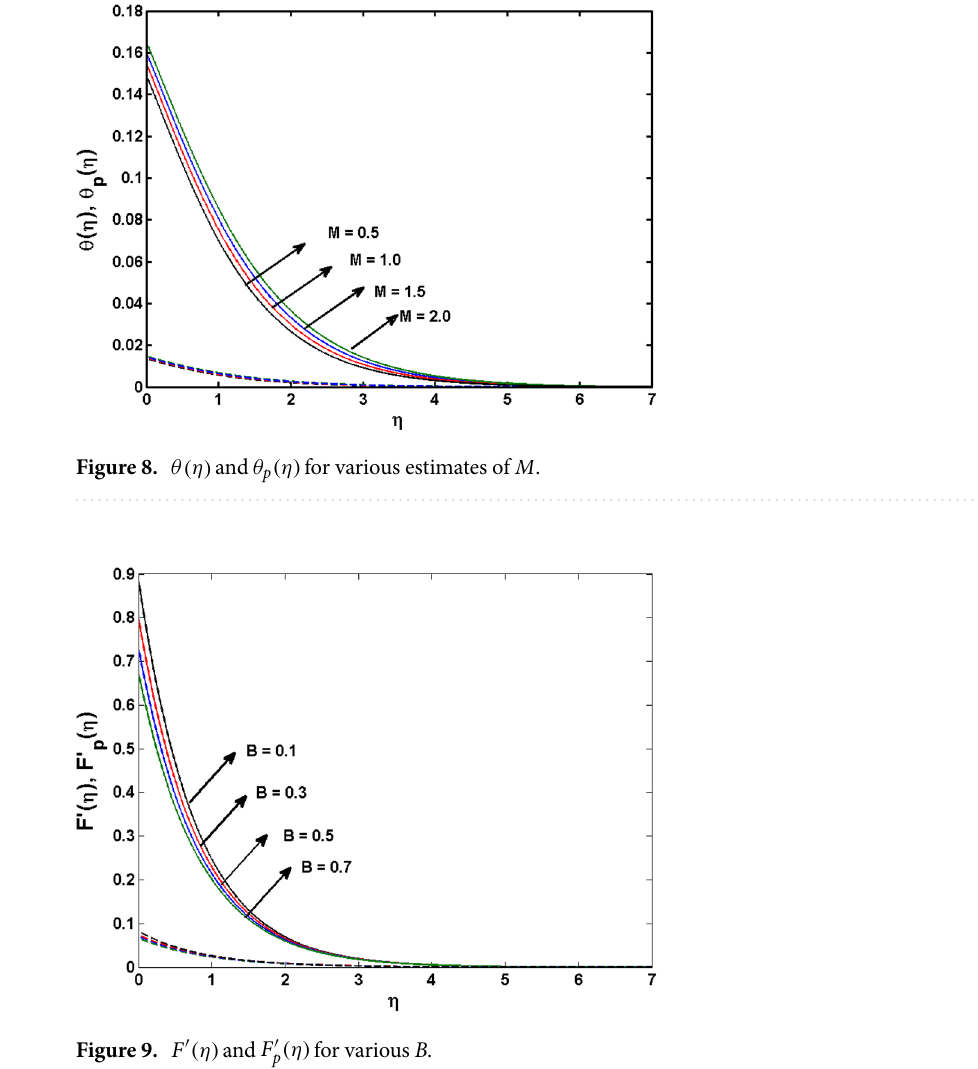
Figure 9. F ′ (η) and F ′ p (η) for various B .